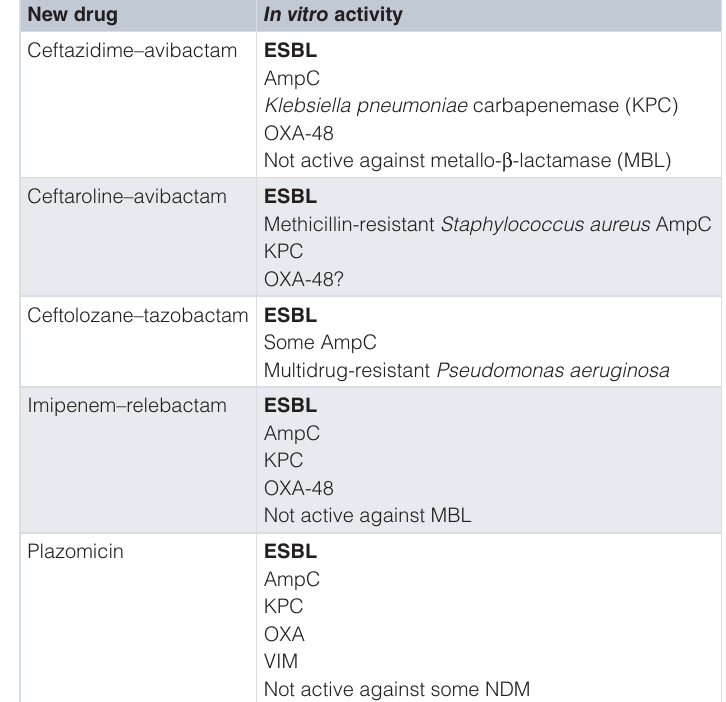
Table 2. New drugs with in vitro activity against extended-spectrum β -lactamase-producing Enterobacteriaceae